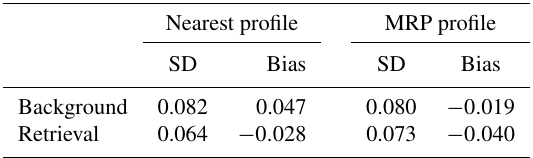
Table 5. The standard deviation and biases (observation versus background or retrieval) of the retrievals using different background profiles.